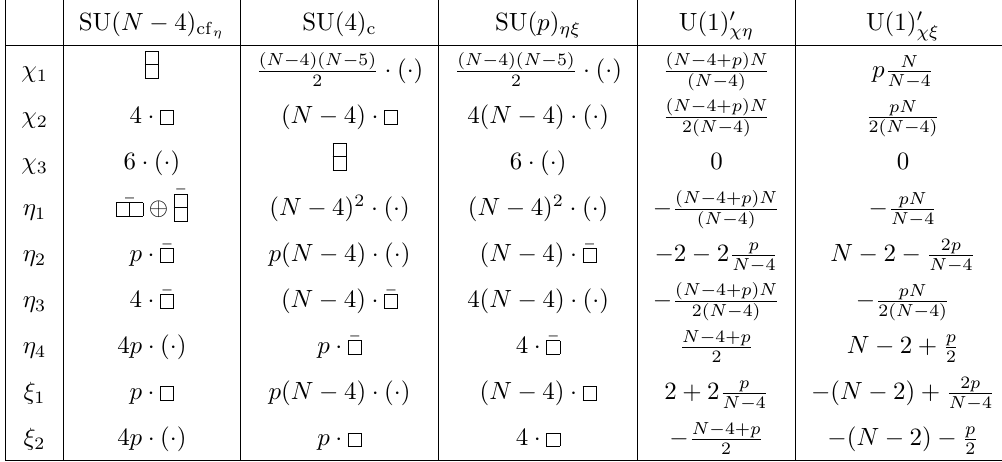
Table 12 . UV fieds in the GG model, decomposed as a direct sum of the representations of the unbroken group of eq.